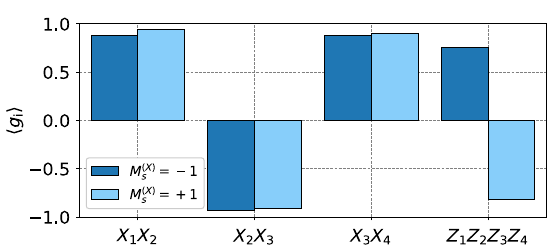
FIG. 9. Expectation values of stabilizer generators of the four- qubit GME state. About 330 per X -type stabilizer and 990 shots for the Z -type stabilizer are acquired. The results are conditioned on the readout result M ð X Þ s of the syndrome. The average shot- noise errors are about 2 × 10 − 2 for all stabilizer